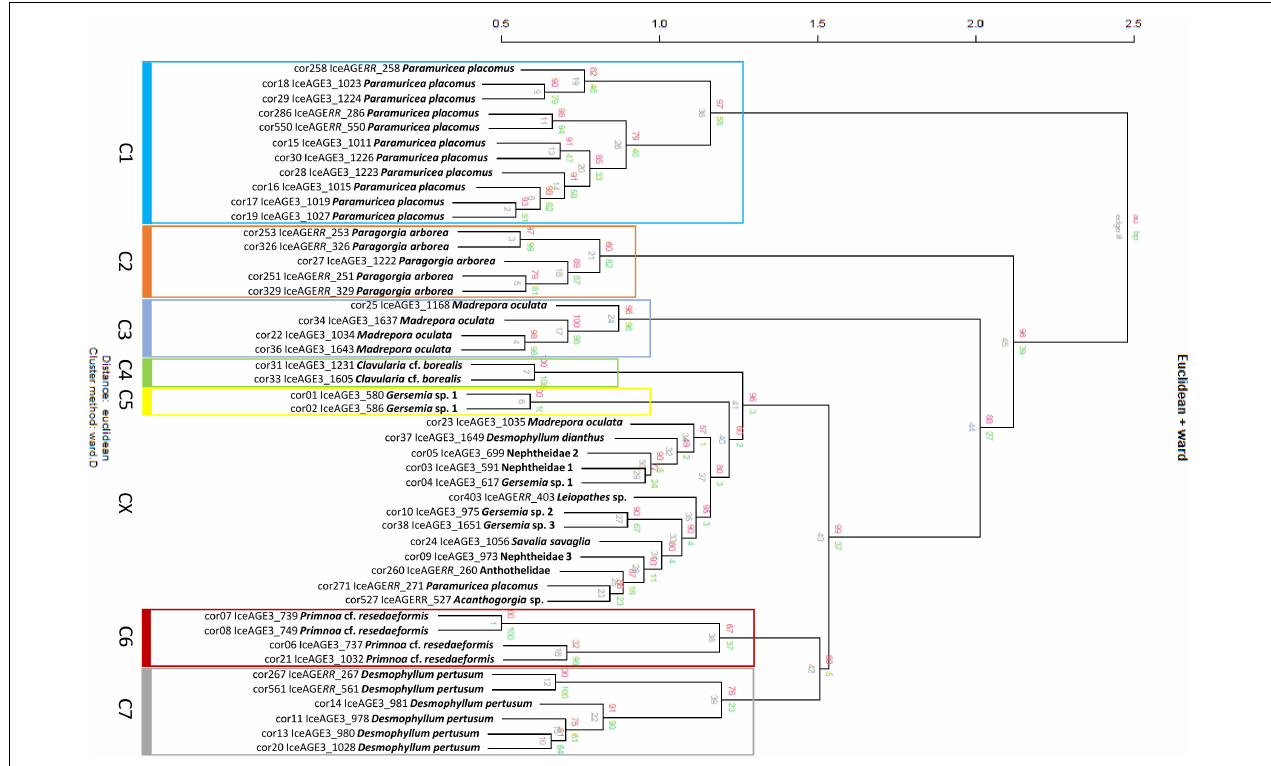
FIGURE 4 | Hierarchical clustering of 47 individual Octocorallia and Hexacorallia samples resulting in seven well-supported clusters with discriminated species. The clusters of discriminated species are framed in color. Cluster CX shows singletons and unassignable specimens.